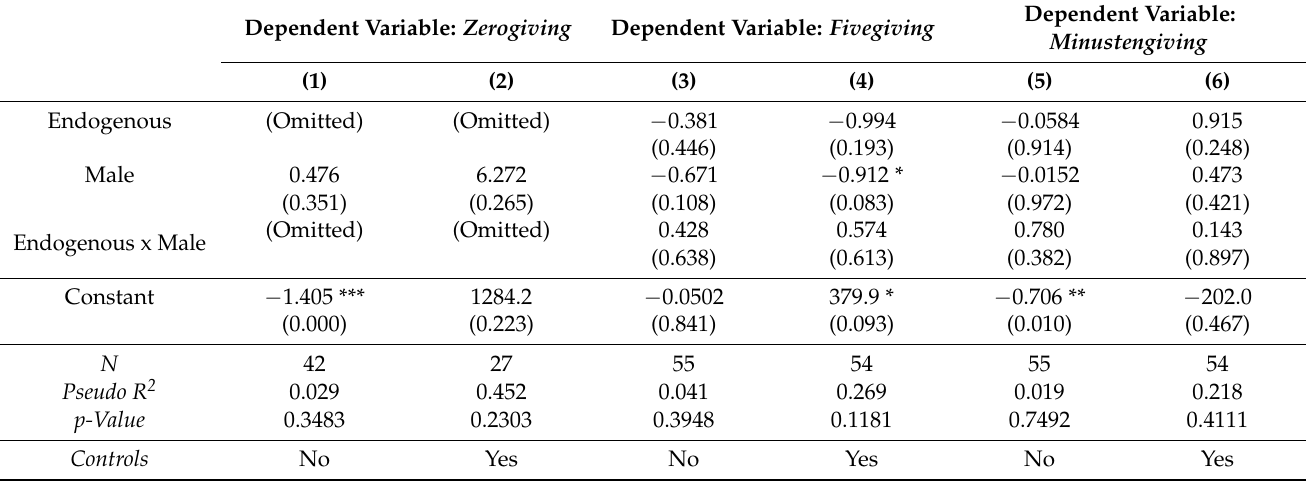
Table A2. Probit regression results for taking games.